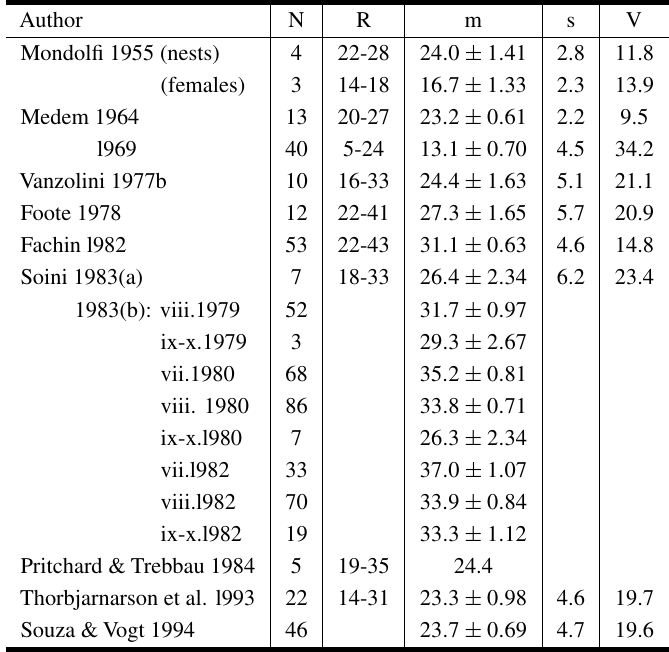
Podocnemis expansa , data on clutch size.